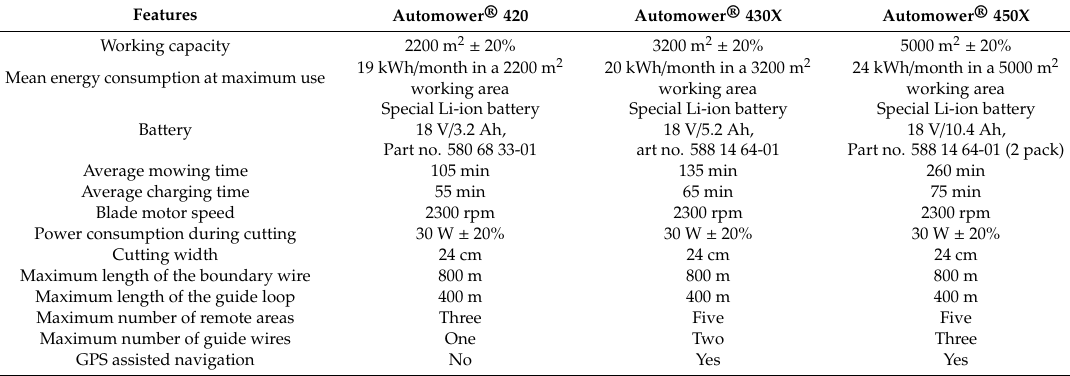
Table 1. Technical features of the Husqvarna autonomous mowers involved in this study.